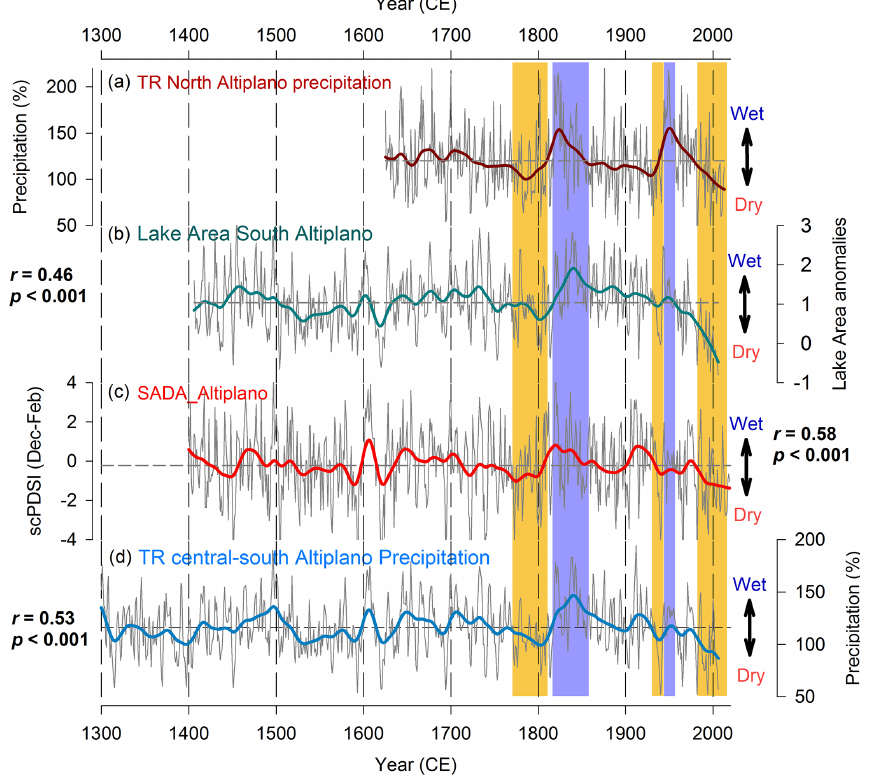
Figure 7. Comparison among four hydroclimate tree-ring-based reconstructions from the South American Altiplano. From top to bottom: (a) precipitation from the northern sector of the Altiplano (this study), (b) lake area variations from the southwestern Altiplano, (c) scPDSI from the entire Altiplano (17–23 ◦ S, 66–70 ◦ W), and (d) precipitation from the central and southern Altiplano. Shaded background represents long-term drought (yellow) and wet period (light blue) coincidences among the four reconstructions. The 35-year smoothed spline (thick colored lines) highlights the multi-decadal variability in the four hydroclimate tree-ring-based reconstructions. Correlation coefficients ( r and p values) between the northern Altiplano precipitation reconstruction and each hydroclimatic reconstruction are indicated with black numbers in their corresponding panels for the common period